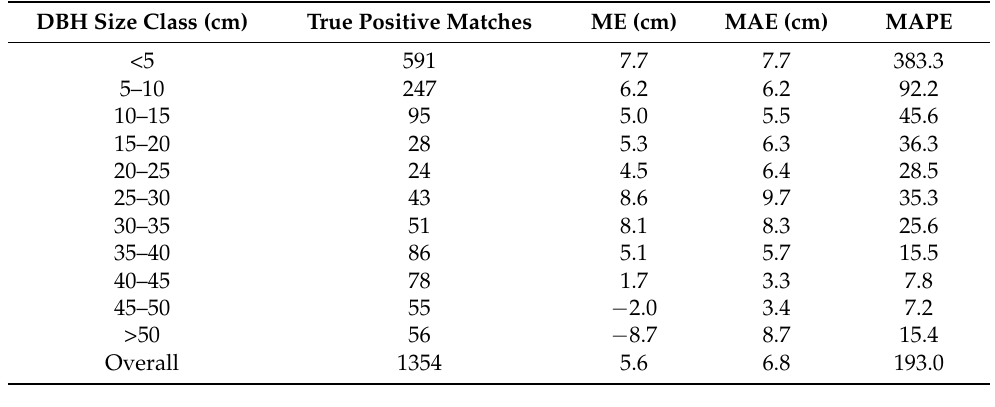
Table 3. Comparison of simple linear model DBH predictions (built from filtered SfM DBHs) against stem mapped observations for all True Positive matches.